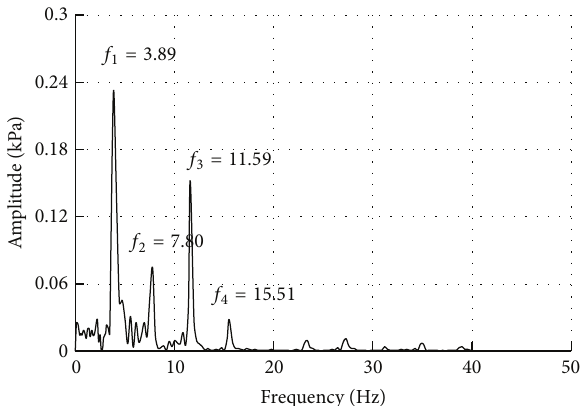
Figure 9: The frequency spectrum curve of dynamic soil pressure at the surface of subgrade ( V = 350 km/h).